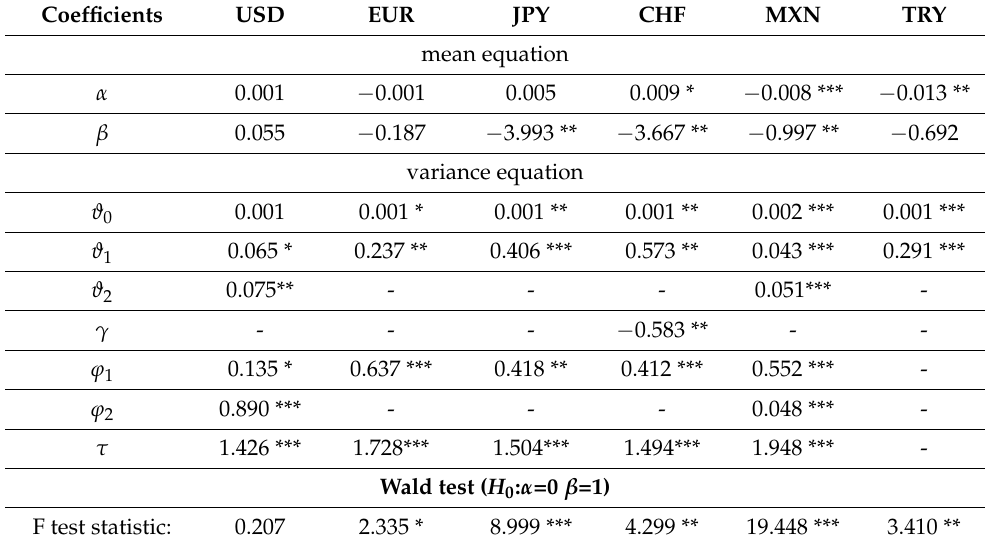
Table 2. Testing the Uncovered Interest Parity hypothesis on the Polish exchange rate market. The results of the GARCH models (4), (5).